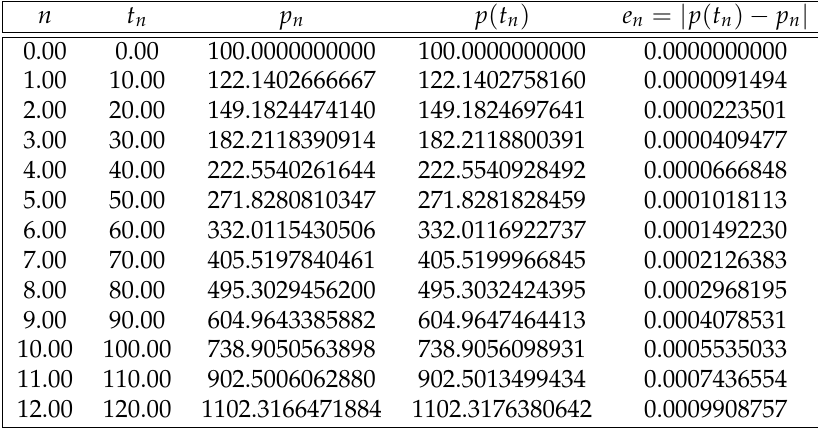
Table 1. The results generated via the scheme (40) and the exact